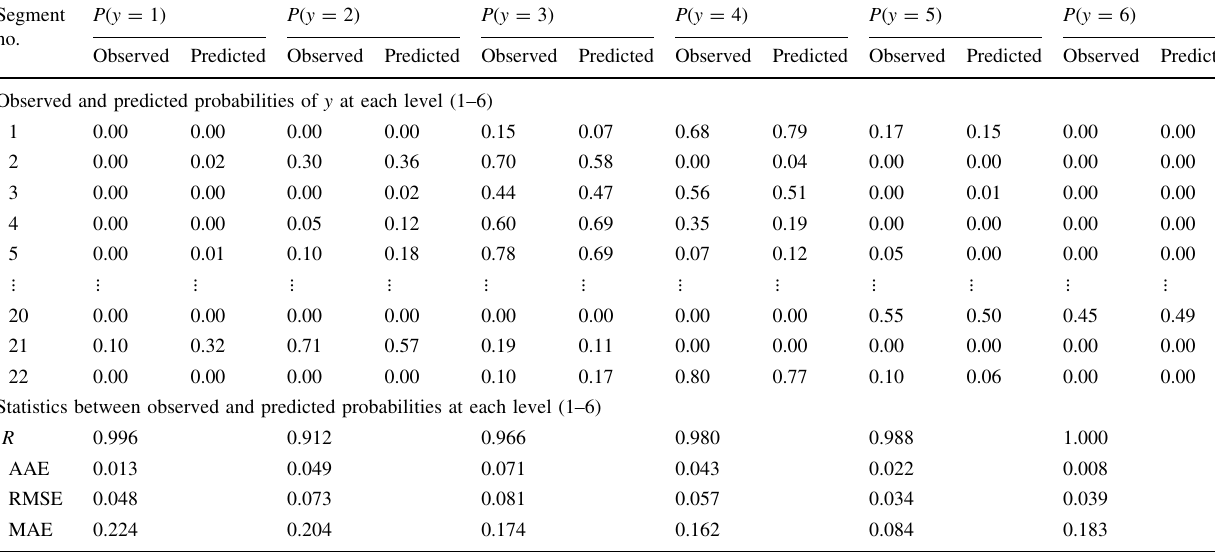
Table 6 Ordered probit model validation with traveler intercept survey data Segment